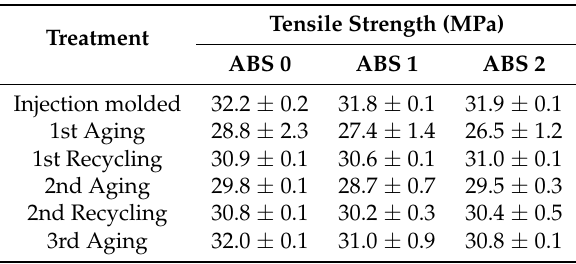
Table 3. Overview of tensile strength of the sample types as covered in Table